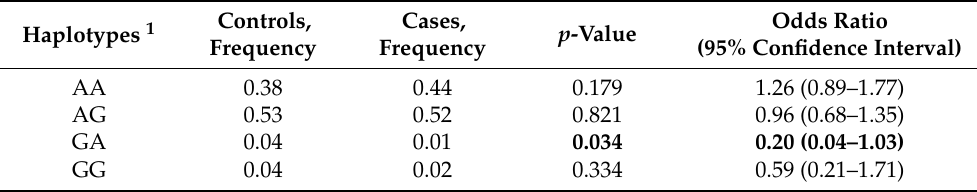
Table 5. Haplotype analysis of DICER1 rs3742330 and DROSHA rs10719 polymorphisms.